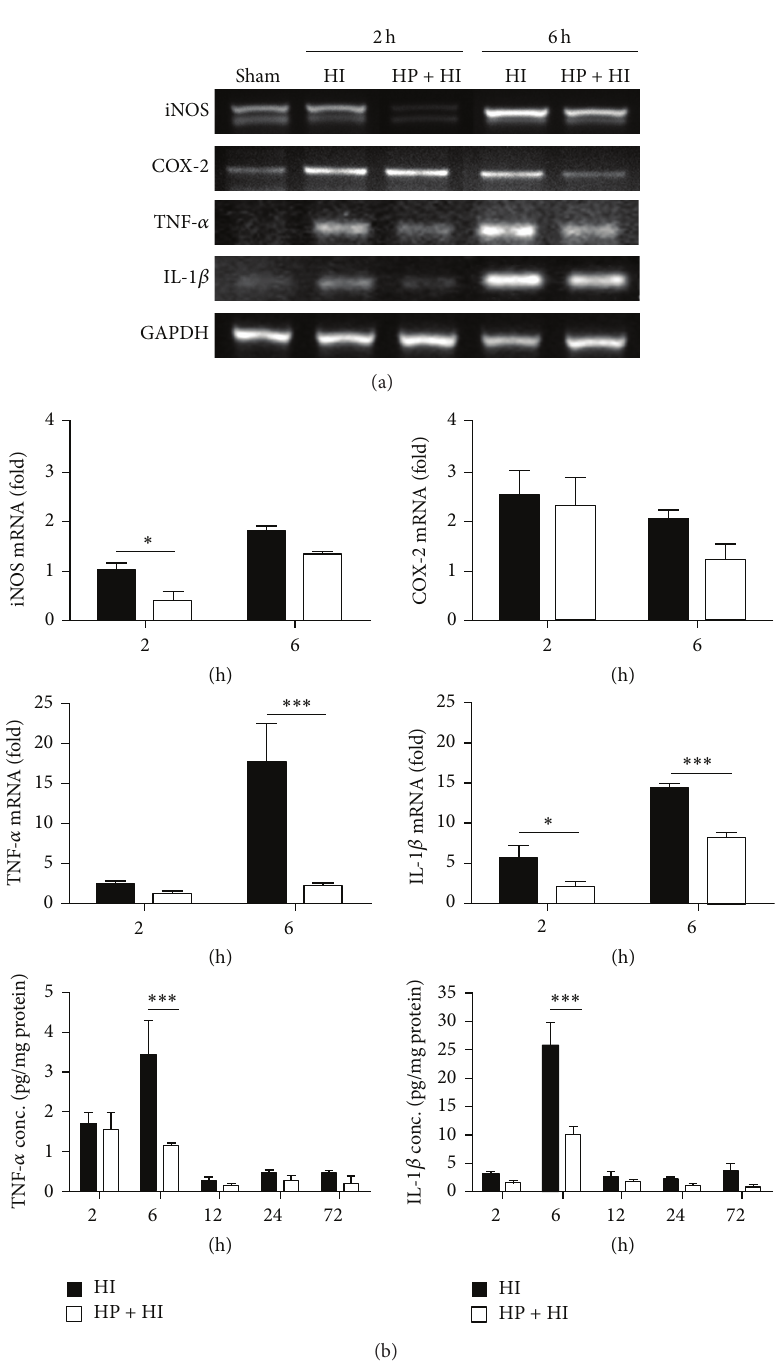
Figure 3: Hypoxia preconditioning reduces proinflammatory gene expression in neonatal hypoxia-ischemia brain injury. (a) The mRNA levels of inducible nitric oxide synthase (iNOS), cyclooxygenase-2 (COX-2), tumor necrosis factor-alpha (TNF- 𝛼 ), and interleukin-1 beta (IL-1 𝛽 ) in the ipsilateral cerebral cortex from neonatal rats were determined at 2 and 6 h after hypoxia-ischemia (HI) injury ( 𝑛 = 4 in each group). The gene expression levels were upregulated by HI injury, especially at 6h after injury. Hypoxia preconditioning (HP + HI) was able to significantly suppress these responses. (b) The protein concentrations of TNF- 𝛼 and IL-1 𝛽 were determined by ELISA at different time points ( 𝑛 = 4 in each group). The suppression of inflammatory mediators in the HP + HI group was significant at 6 h after HI. ((a), (b)) Data represented as the mean ± standard error of the mean (SEM). ∗ 𝑃 < 0.05 compared with HI, ∗∗∗ 𝑃 < 0.001 compared with HI, and 𝑃 = 0.08 for COX-2 mRNA level at 6h for HP + HI group compared with HI